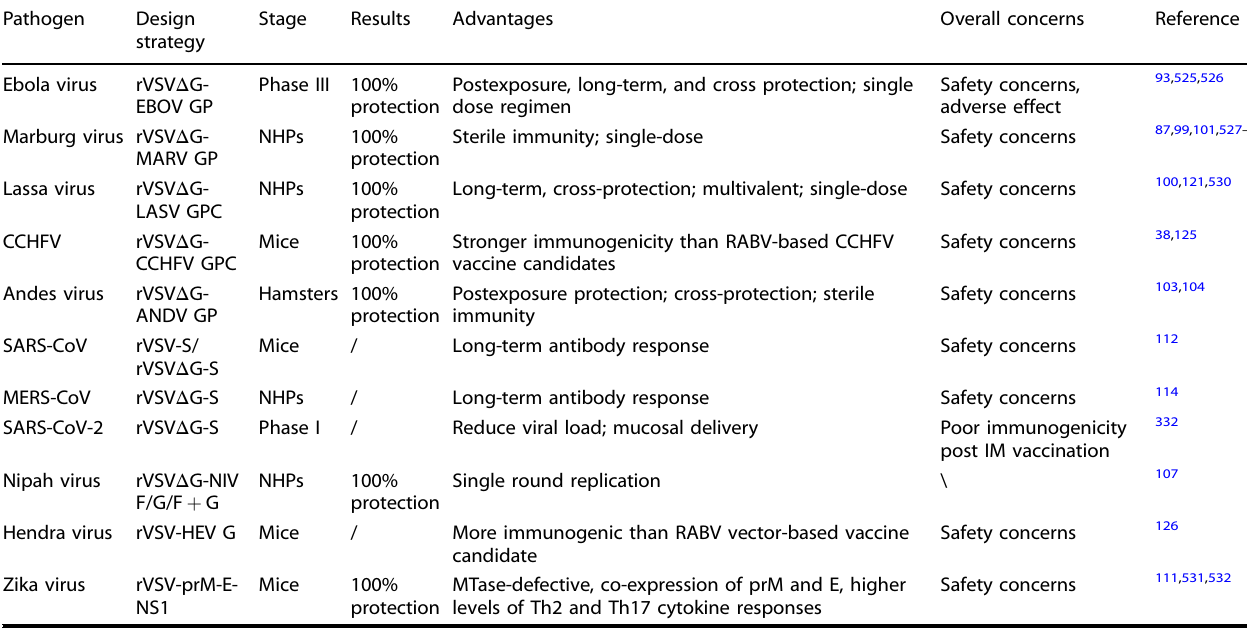
methyltransferase, prM membrane precursor, E